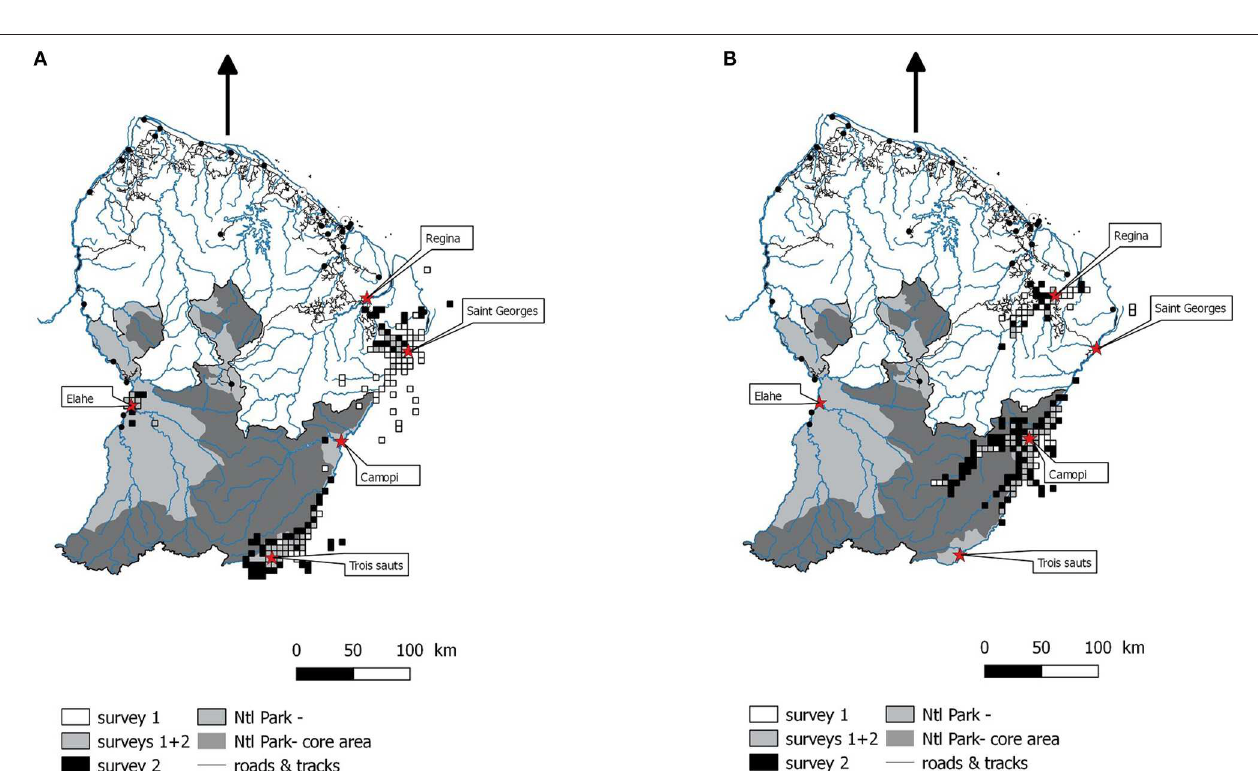
FIGURE 1 | Map of the five study sites, and the catchments areas during surveys 1 and 2. Catchment areas were represented on different maps to avoid overlapping between sites. (A) catchment areas of Trois Sauts, Saint-Georges, and Elahe villages. (B) catchment areas of Camopi and Régina. Each square is a 5 × 5 unit with at least one kill recorded during the considered survey. White cells: catchment during survey 1 only; black cells: catchments during survey 2 only; gray cells: catchments during both